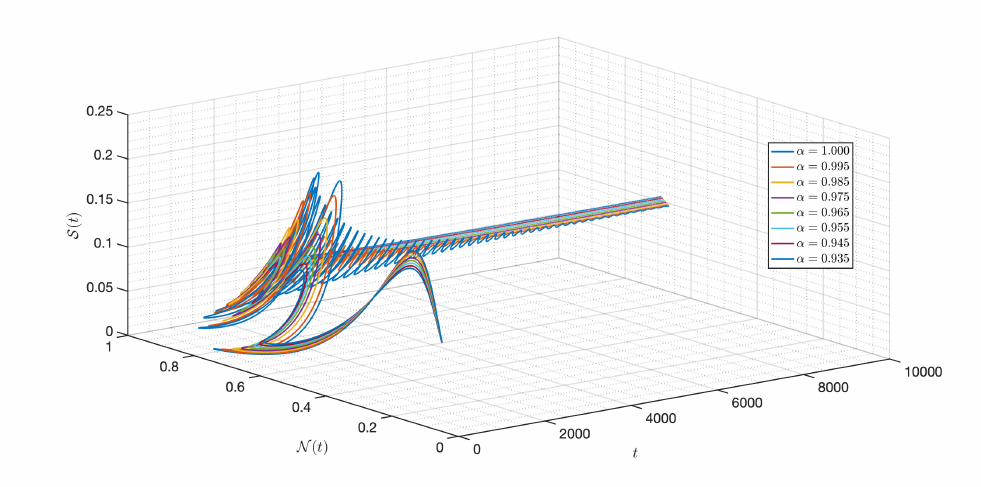
Figure 18. Dynamic of the model (3) for different parameters in Case II .